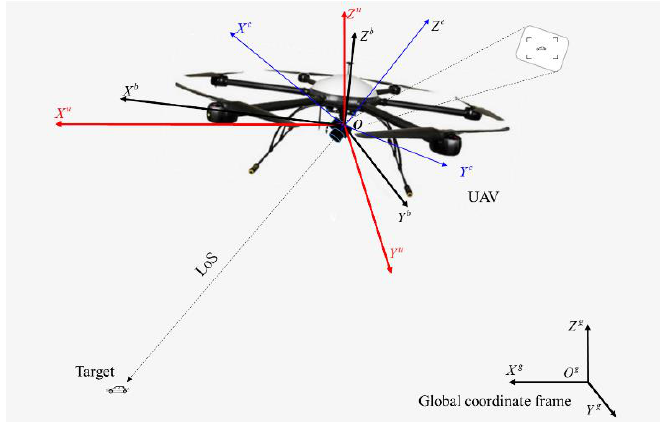
Figure 2. Illustration of coordinate frames.